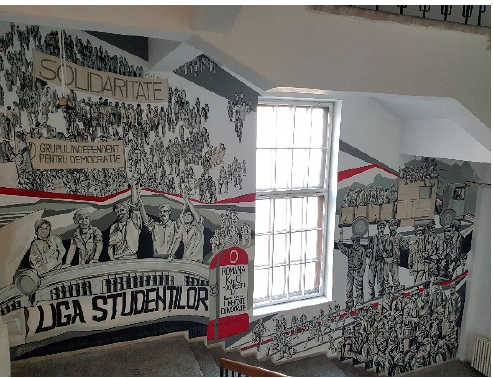
Figure 40. “The University Square phenomenon from 1990”, University of Bucharest by Elann, 2020 (photo taken in 2022).